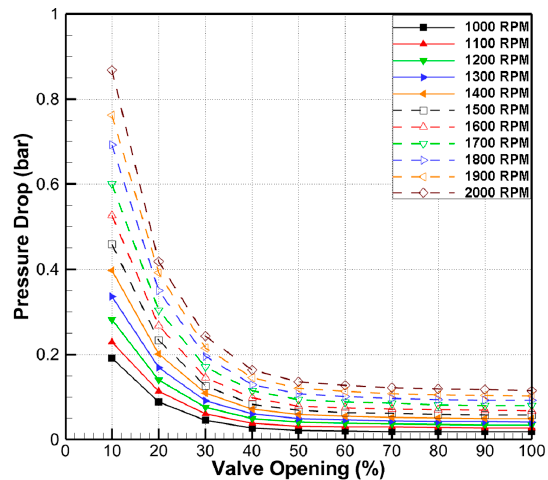
Figure 5. Pressure drop at the globe valve.